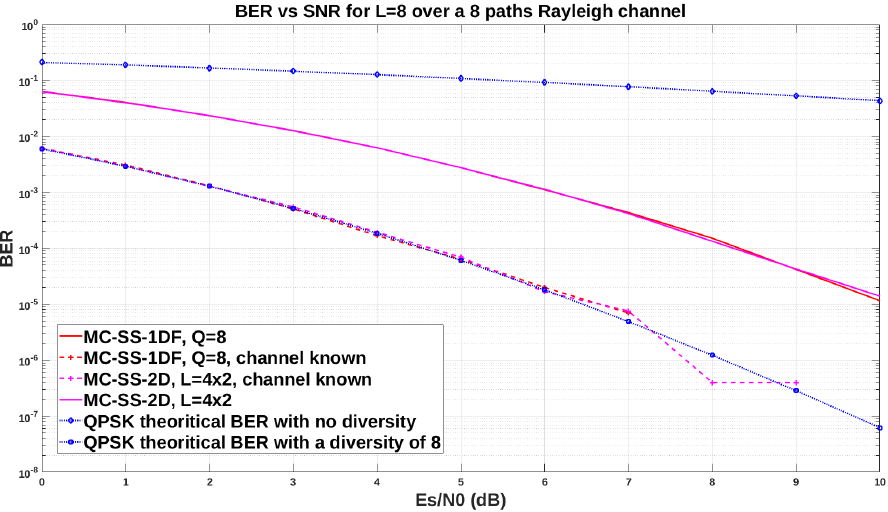
Figure 7. Simulation results over an 8-path Rayleigh block fading channel with a SF of L =